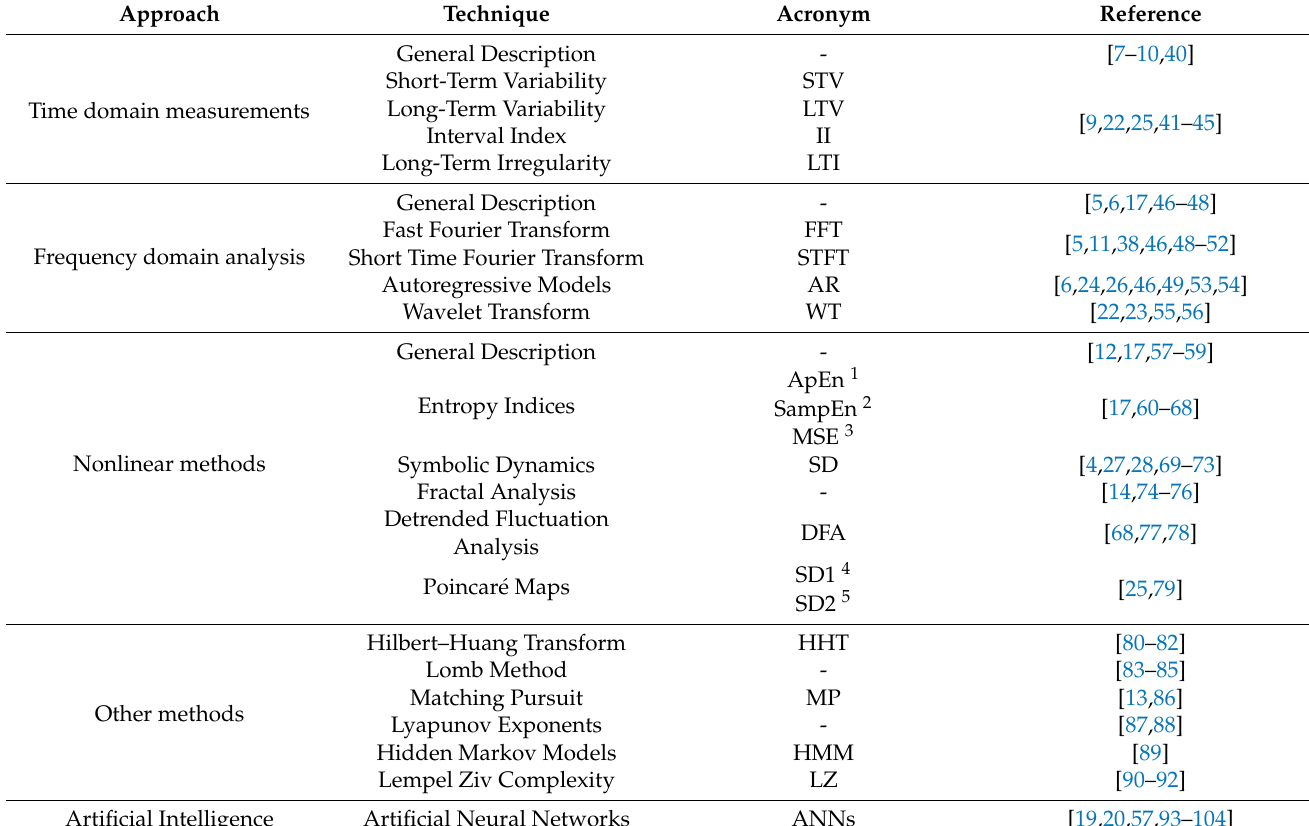
Table 1. Most representative studies included in the qualitative synthesis of the review. Approach Technique